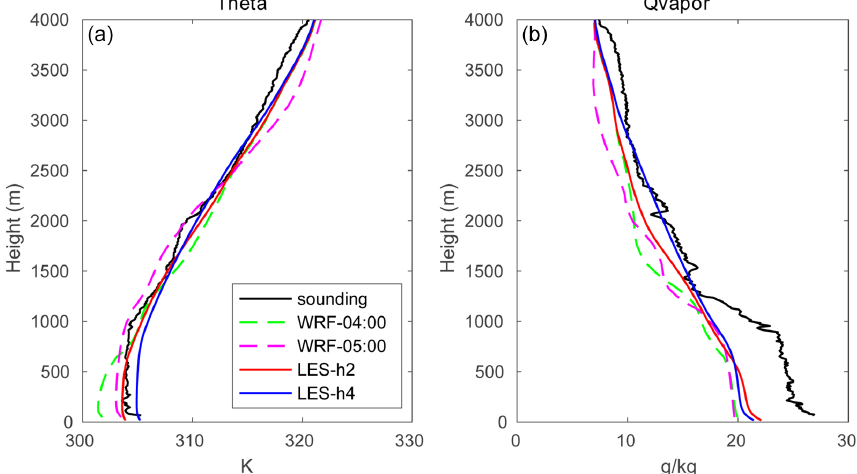
Figure 1. The evolution of the profiles for potential temperature (a) and water mixing ratio (b) from mesoscale WRF (dashed green lines at 04:00UTC; dashed magenta lines at 05:00UTC) and LES (solid red lines for hour 2 from the start time; solid blue lines for hour 4). The measurements at King’s Park station taken at 05:00UTC are shown by black lines (data source: http://www.hko.gov.hk, last access: 13 January 2020).